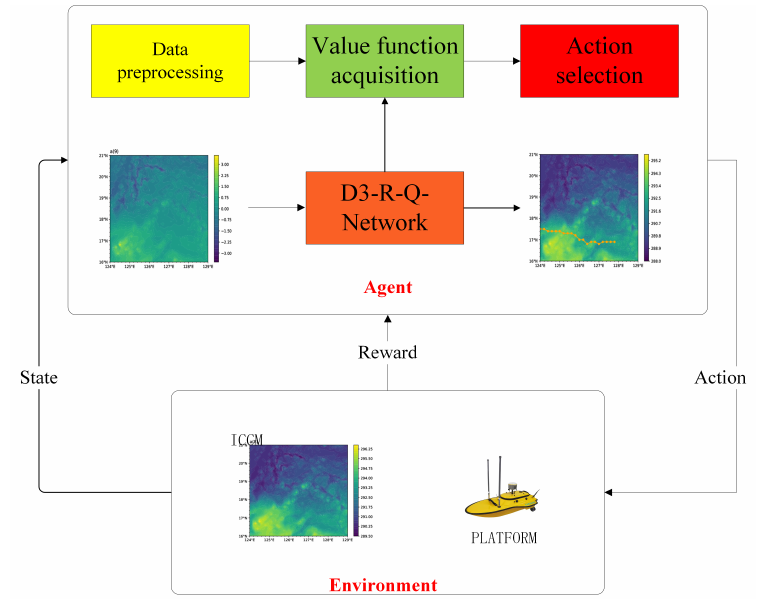
Figure 2. Adaptive observation based on D3RQN.